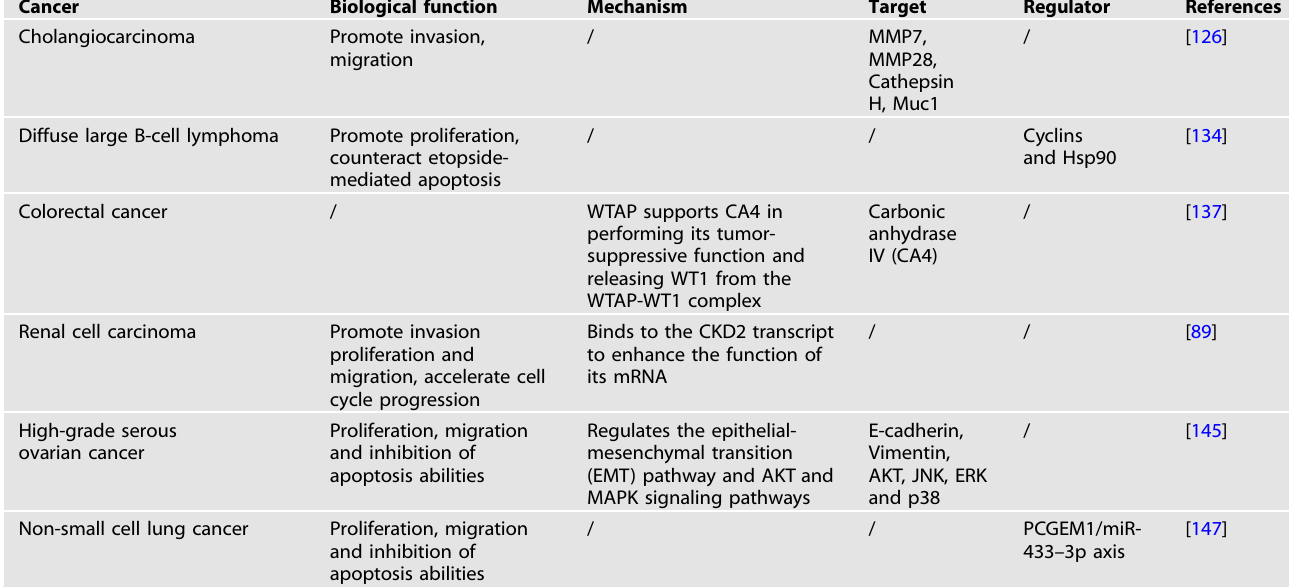
Table 4. Other functions of WTAP in cancer.